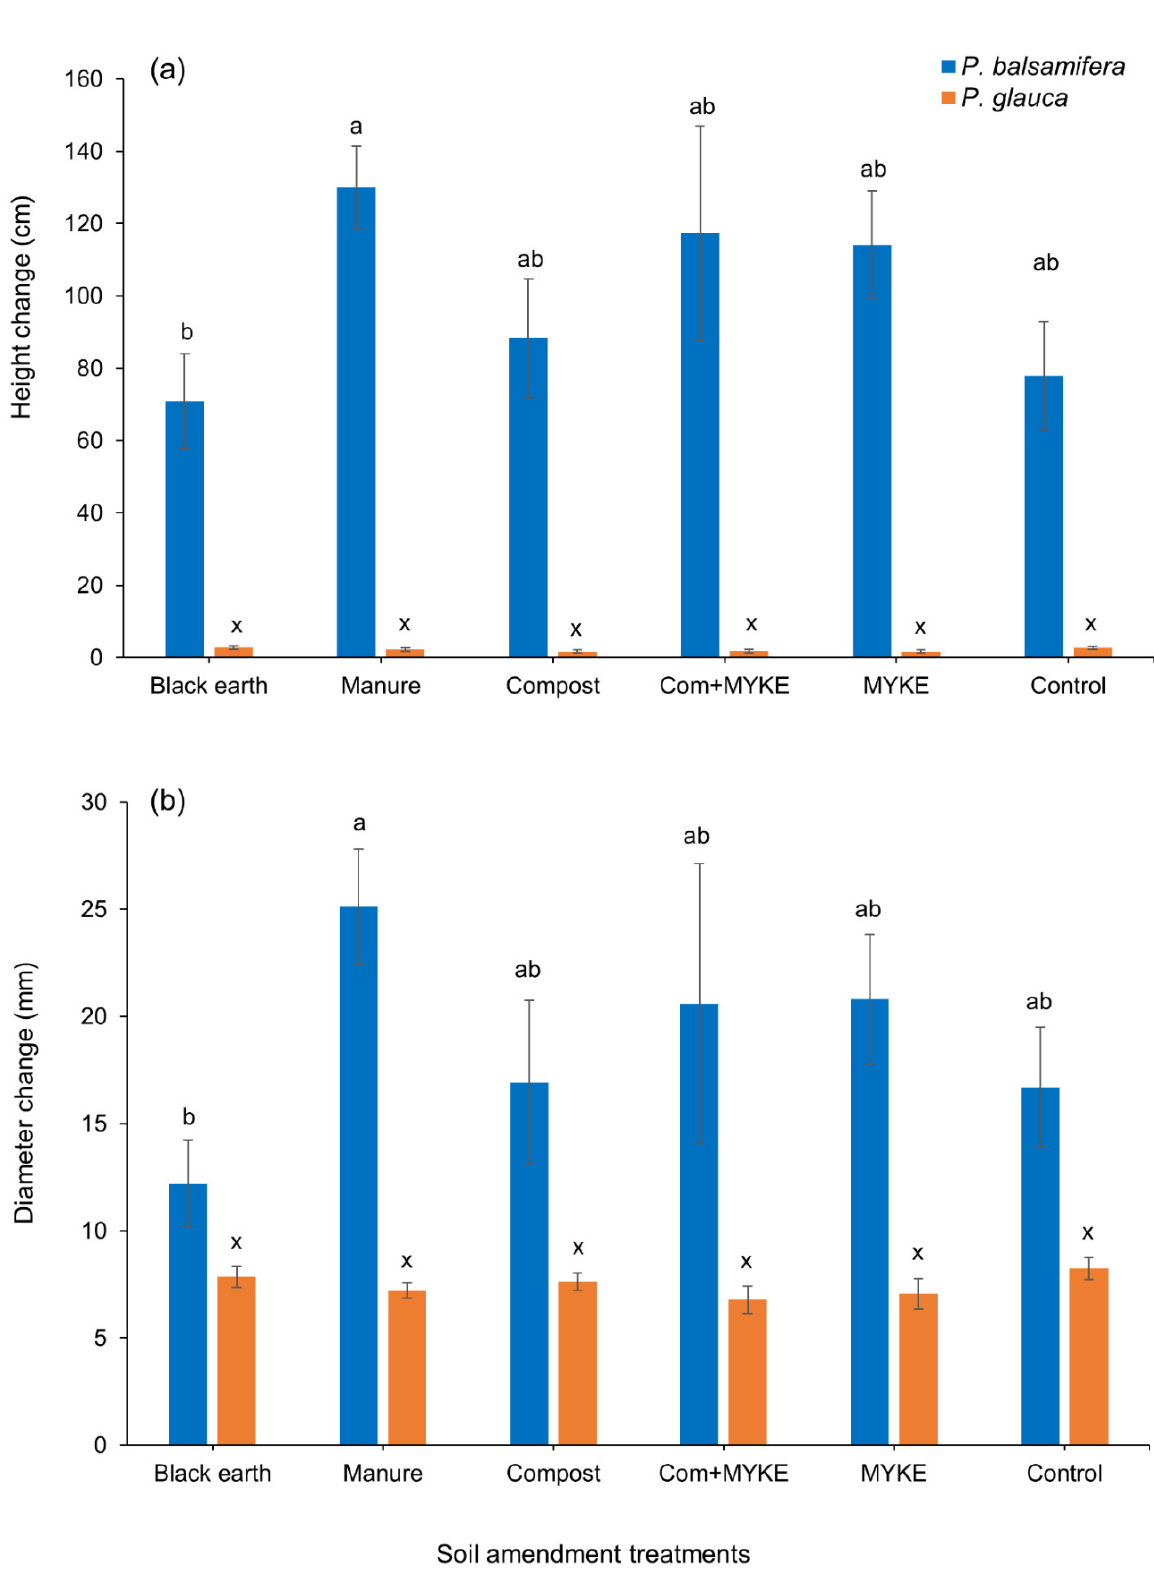
Figure 3. Mean ( ± SE) ( a ) height ( b ) stump diameter change of planted P. glauca and P. balsamifera by amendment treatments. Different letters indicate significant differences at p = 0.05 in the Tukey HSD post hoc comparisons.